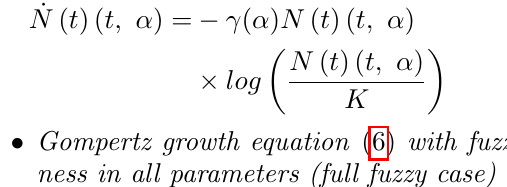
2. Fuzzy transformation mechanism of the Gompertz tumor growth